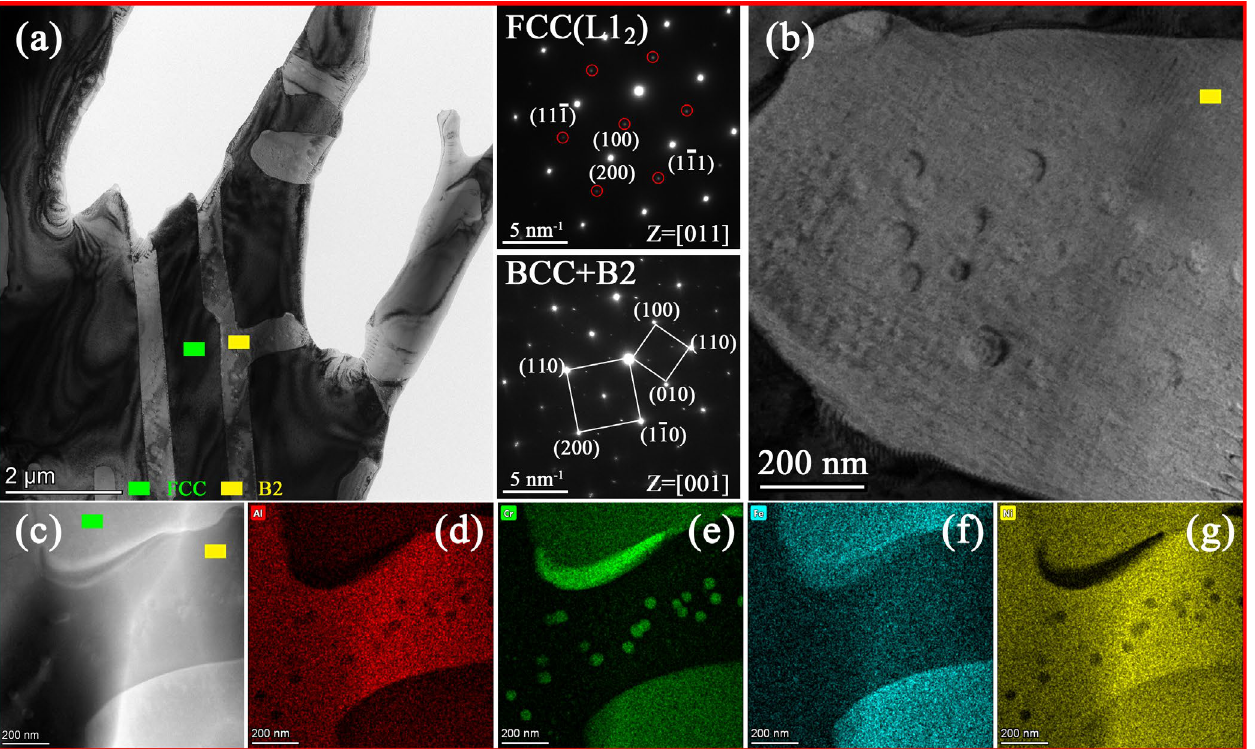
Figure 4. TEM analysis results of the AlCr 1.18 FeNi 2.8 . alloy. ( a ) Bright-field image; ( b ) High magnified image of the B2 phase; ( c ) HAADF–STEM image; ( d – g ) Elemental distribution EDS maps.